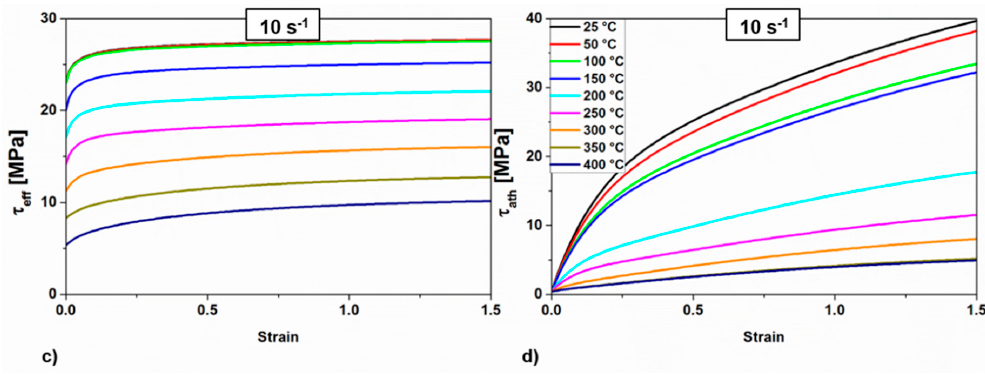
Figure 11. Effective and athermal stresses calculated for all temperatures and ( a , b ) 0.1 s − 1 and ( c , d ) 10